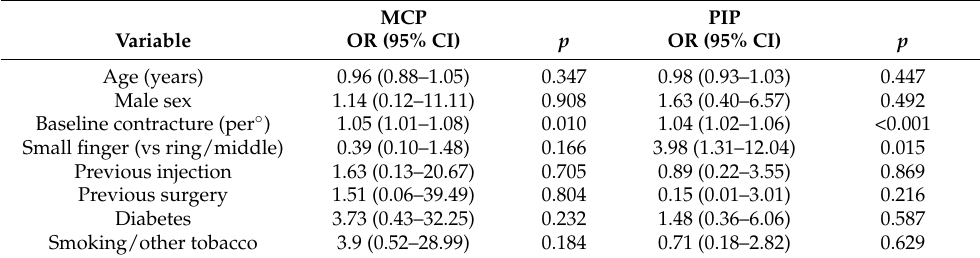
Table 4. Risk factors of recurrence at 5 years; repeat injections were not considered as recurrence.